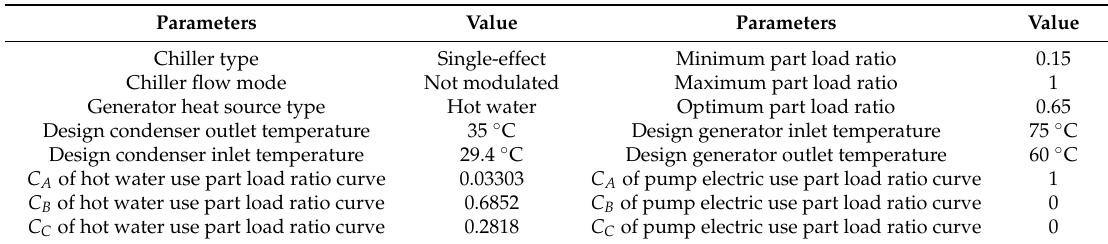
Table 7. Simulation input parameters for the absorption